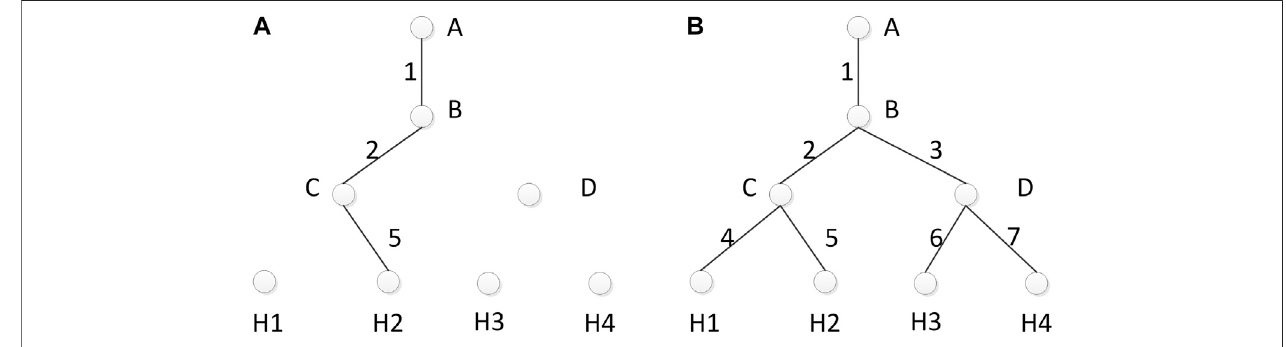
FIGURE 3 | Example of a multicast tree in two adjacent time slots. (A) the multicast tree in time slot t. (B) the multicast tree in time slot t+1.